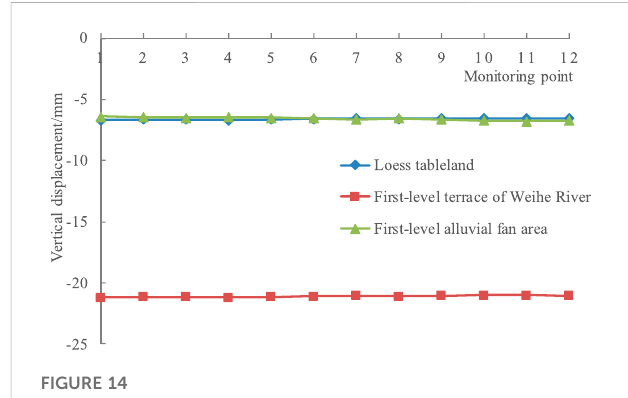
FIGURE 11 Vertical displacement curves of monitoring points in the pipe gallery.